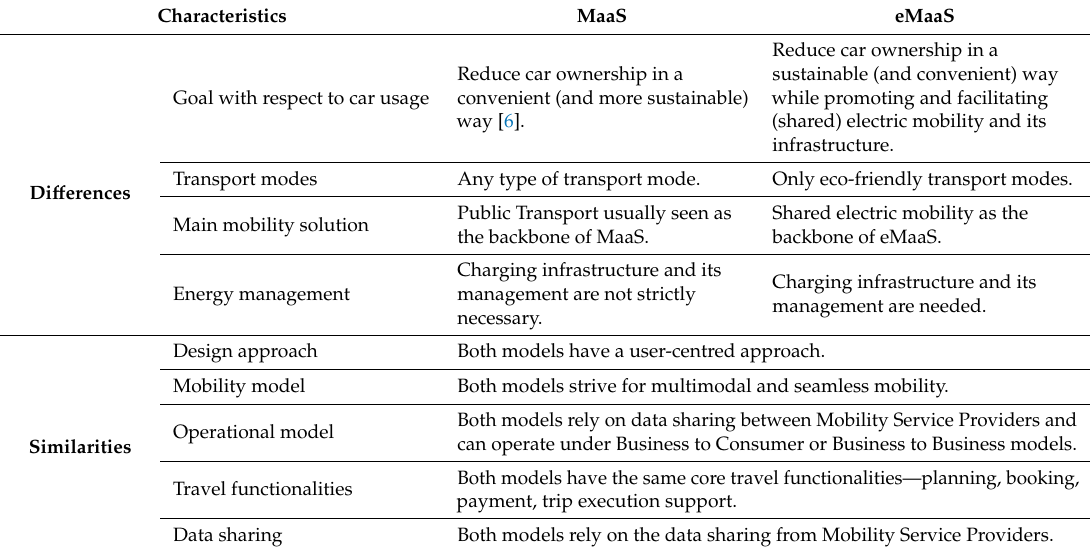
Table 1 o ff ers an overview of the main di ff erences and similarities between the MaaS and the eMaaS models. As mentioned before, the eMaaS model relies on the MaaS model itself, therefore any other key characteristics of MaaS that are not mentioned in the table should be considered to be equal for both models. Moreover, with the increasing electrification of most transportation means and also the increasing o ff er of shared mobility services, a di ff erentiation between both models will most likely not be needed in the mid-term future. Most of the MaaS characteristics presented in Table 1 are based on the definitions of MaaS by various authors as presented in the work by Sochor et al. [5]. Table 1. Main di ff erences and similarities between the Mobility as a Service (MaaS) and the electric Mobility as a Service (eMaaS)